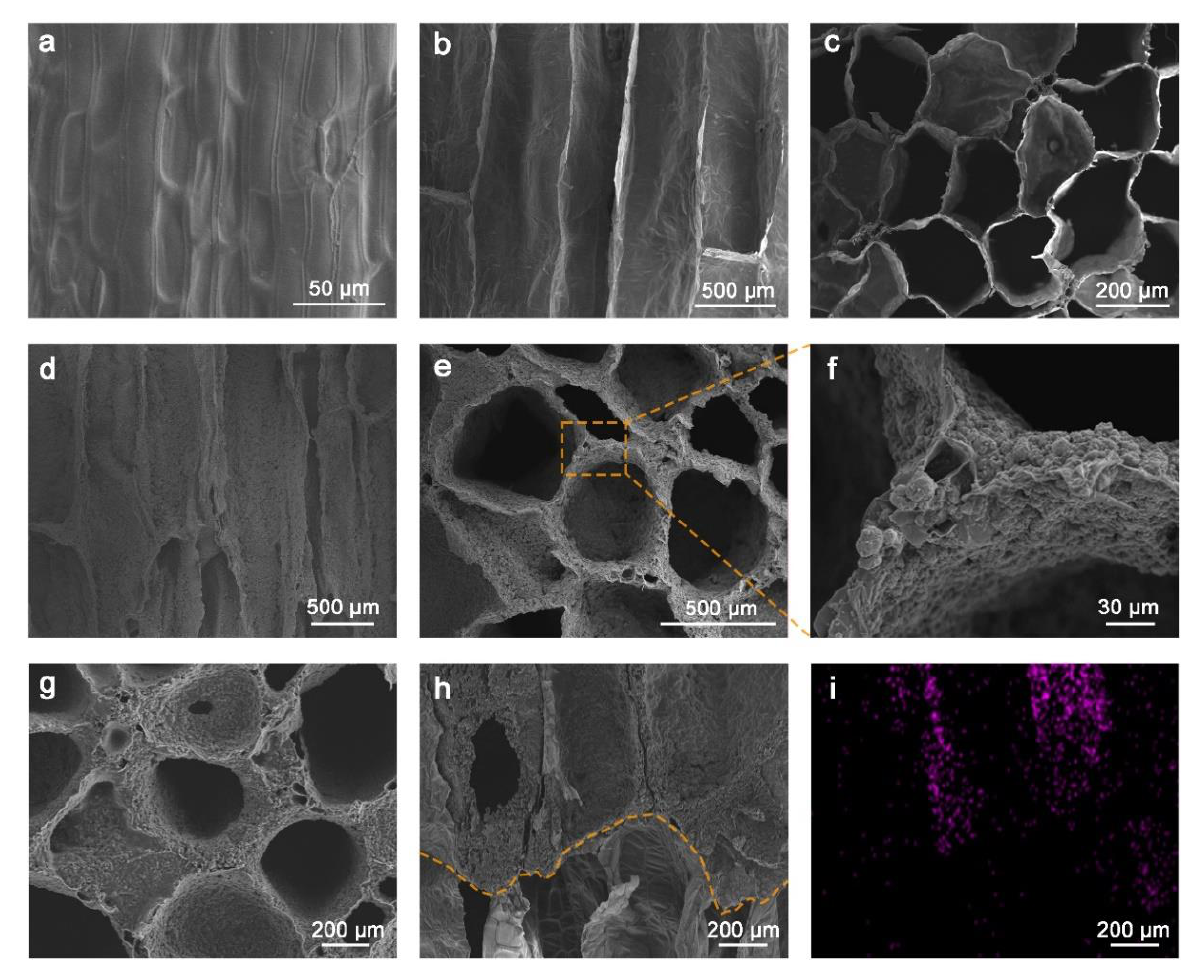
Figure 2. SEM images of ( a ) WHP with epidermis, ( b ) axial-sectional WHP, ( c ) radial-sectional WHP, ( d ) axial-sectional WHP-C, ( e , f ) radial-sectional WHP-C, ( g ) radial-sectional WHP-CH, ( h ) axial- sectional WHP-CH. ( i ) EDS mapping showing the distribution of fluorine (F) element in ( h ).